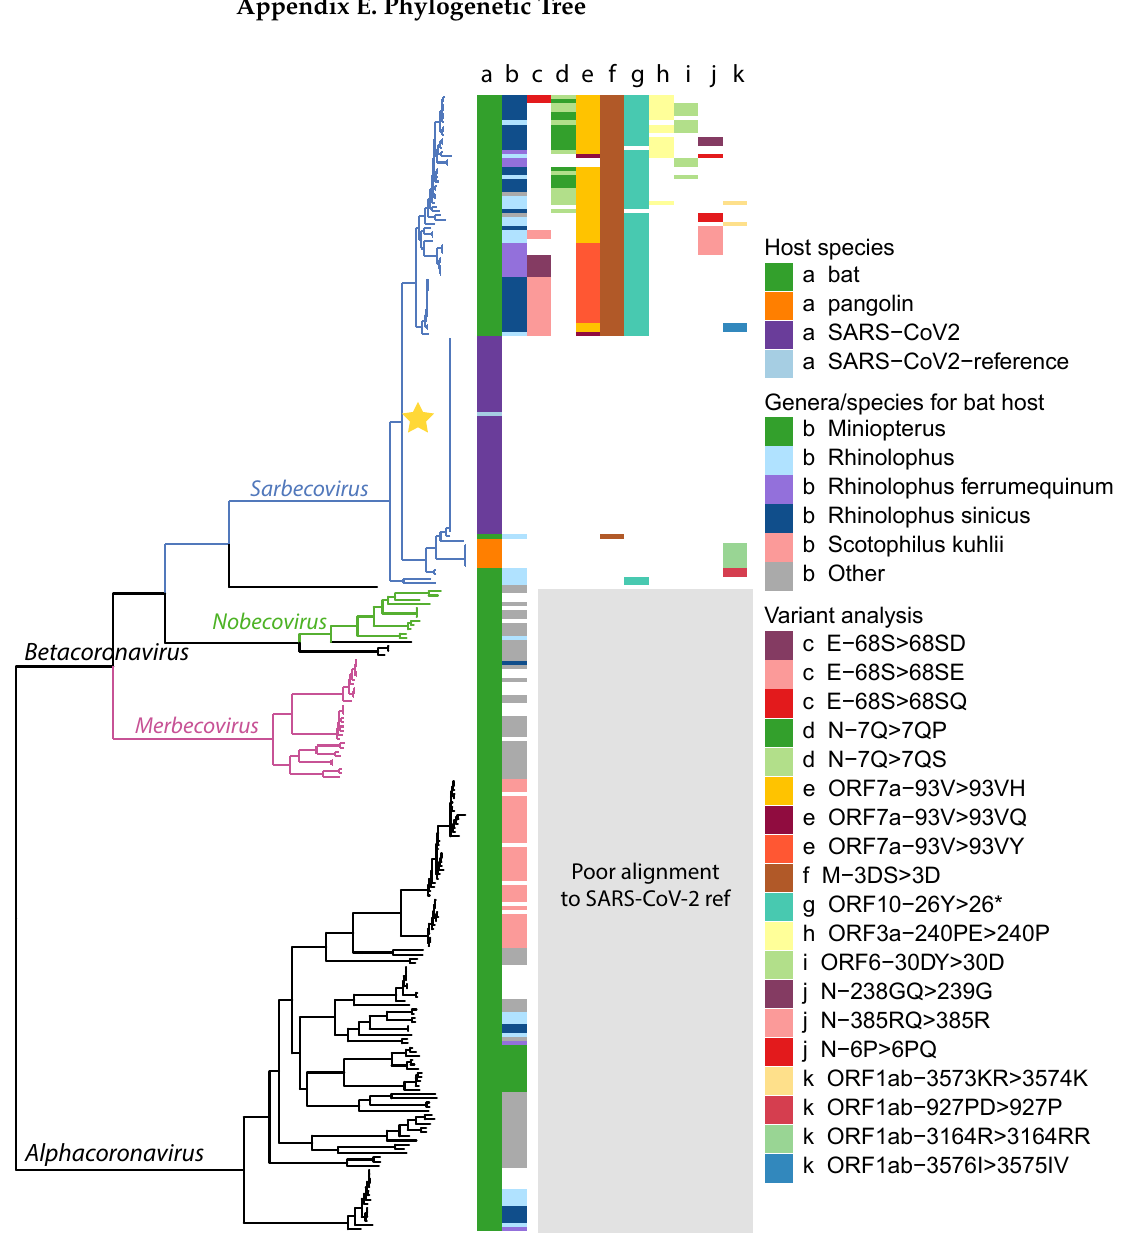
Figure A5. Ladderised phylogenetic tree of bat-CoV, pangolin-CoV and SARS-CoV-2 (Wuhan dataset and reference) genomes. The hosts for each genome are indicated in (a) and host genera or species in (b) for bat-CoV. The majority of the Sarbecovirus affect the bat genus Rhinolophus (column b, light blue, dark blue and purple), whereas a much smaller proportion of the Alphacoronavirus are found in bats of this genus. Some clades overlap with specific bat species, including Rhinolophus ferrumequinum , Rhinolophus sinicus and Scotophilus kuhlii . Several high impact variants (inframe insertion, inframe deletion or stop gain) identified from variant analysis overlap with the clades in the phylogenetic tree. The annotation indicates (c–e) amino acid positions with multiple variants, (f–i) amino acid positions with a single change and found in >10 genomes, (k, l) other variants. The genes and amino acid changes involved in each of the annotated in-frame insertion, in-frame deletion or stop gain (*) are indicated in the figure legend. Star highlights the clade in Figure